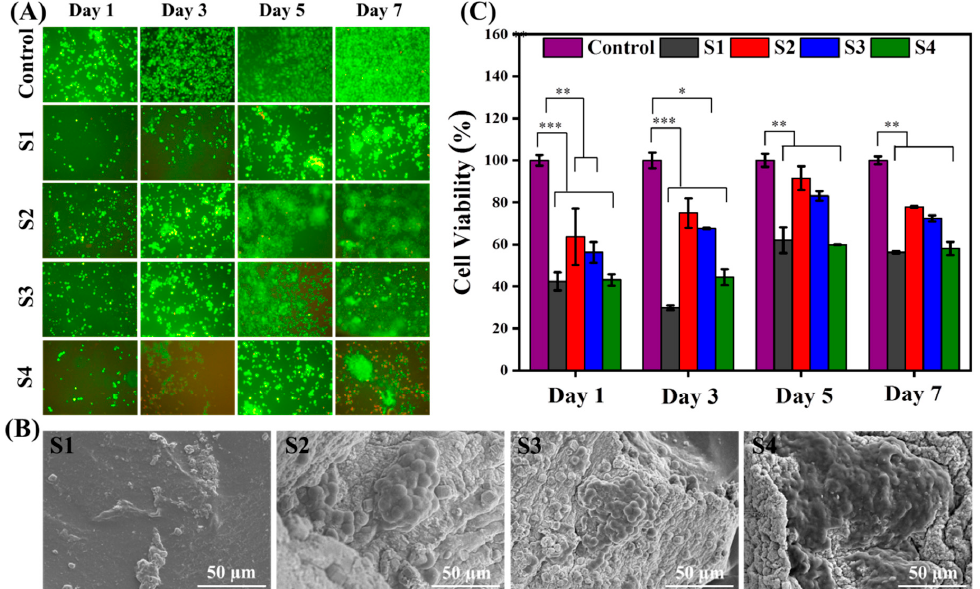
Figure 7. ( A ) Fluorescence images of live/dead assay; ( B ) SEM images of S1, S2, S3, and S4 hydrogels after 7 days of cell culture; and ( C ) MTT assay for control and S1, S2, S3, and S4 hydrogels, respectively, after 1, 3, 5, and 7 days of cell culture (L929 fibroblast). *** p ≤ 0.001, ** p ≤ 0.01, * p ≤ 0.05.